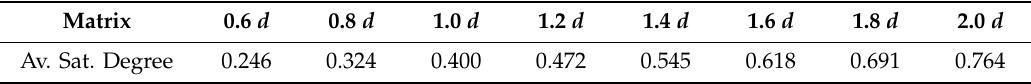
Table 5. Average saturation degrees on the urban real-scale network.